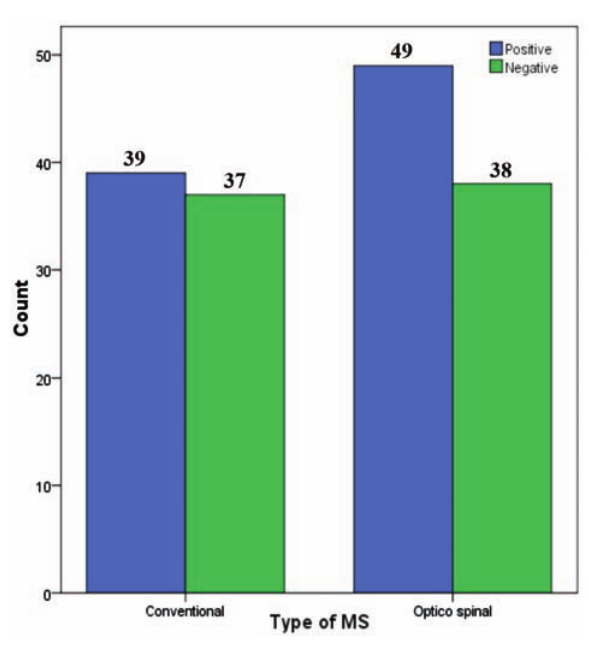
Figure 1. Comparison of anti- Helicobacter pylori test results between multiple sclerosis patients and control group.